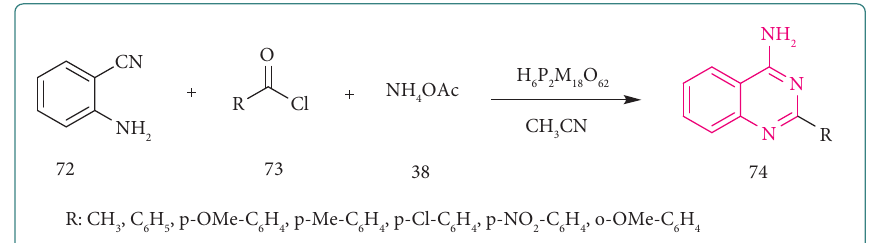
Scheme 13: Synthesis of 4-aminoquinazoline derivatives in the presence of Dawson-type heteropolyacids (HPAs) catalysts.